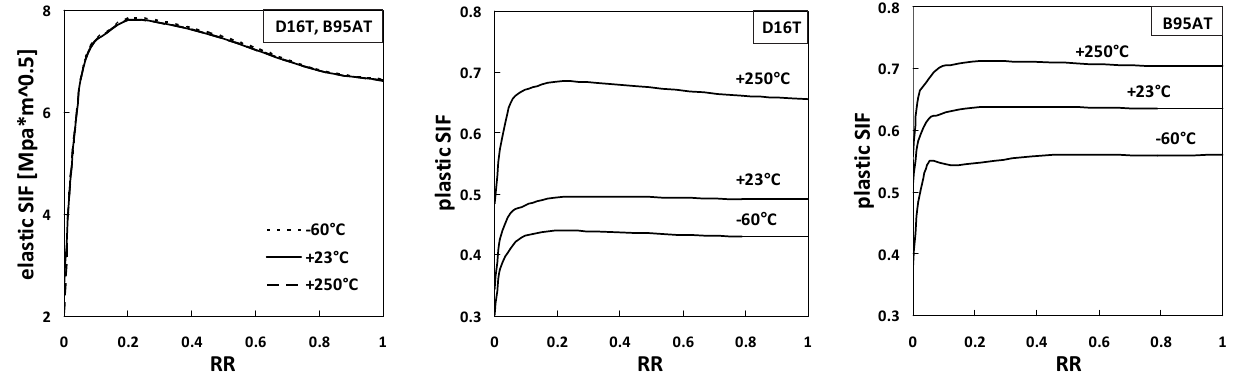
Figure 8: Elastic and plastic SIF distributions for initial crack